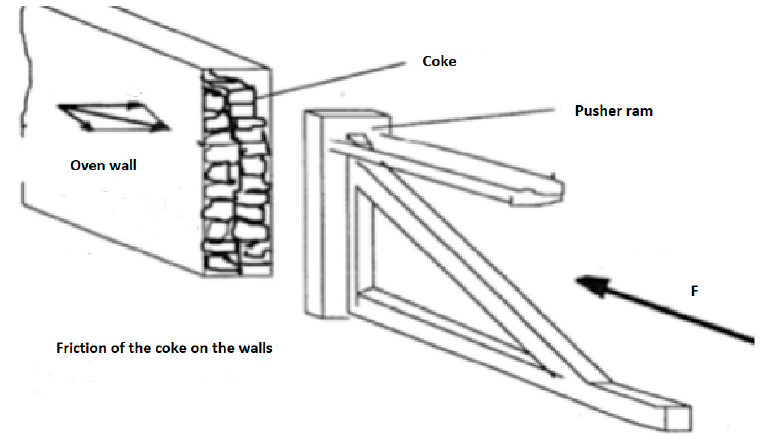
Figure 1. Friction of the coke cake on the oven walls.